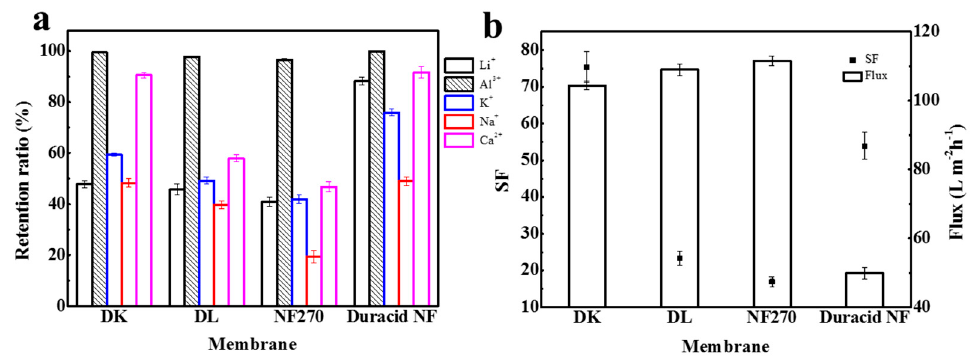
Figure 11. ( a ) The retention ratio of Li + , Al 3 + , K + , Na + and Ca 2 + ; ( b ) SF and flux of four NF membranes. Table 11. Retention ratio of Li + , Al 3 + , K + , Na + , and Ca 2 + ; SF; flux and permeate pH of four NF